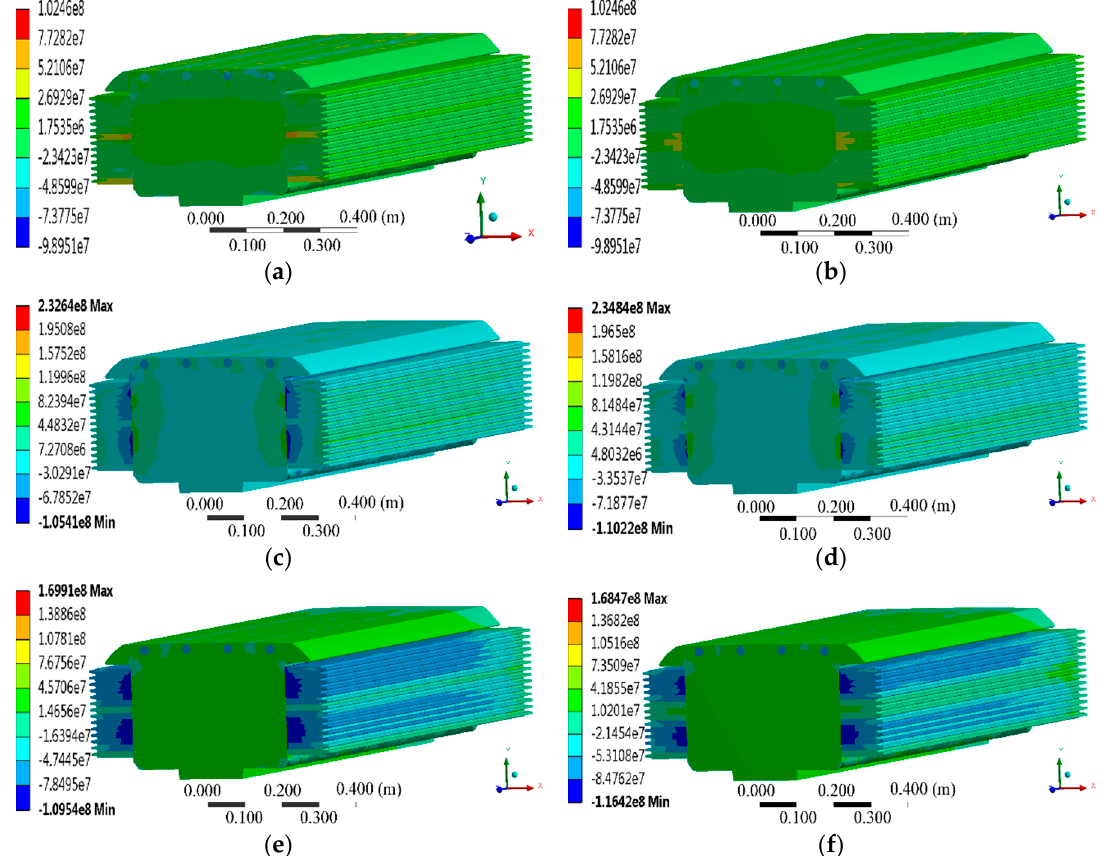
Figure 16. Thermal stress in the X/Y/Z direction in inter-turn short circuit: ( a ) 1-x; ( b ) 3-x; ( c ) 1-y; ( d ) 3-y; ( e ) 1-z; and ( f ) 3-z.